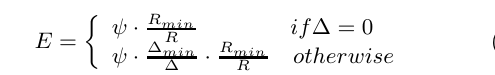
scale responding to the user needs fulfilling the QoS com- mitted in the SLA with optimum accuracy, speed and